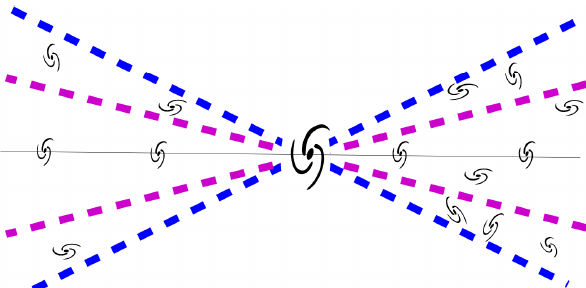
Figure 10. If a filament threads two or more galaxies before significantly bending, their rotation planes (perpendicular to the dark matter rope tying them) are parallel. Since the filaments are not visible in principle, one needs to correlate a distribution of galaxies. However, knowing that it is perpendicular to the spiral rotation plane, noise-reduction strategy is to not include all the space surrounding a given galaxy but, rather, to span only a cone given by a certain opening angle θ and then tighten that angle to improve the